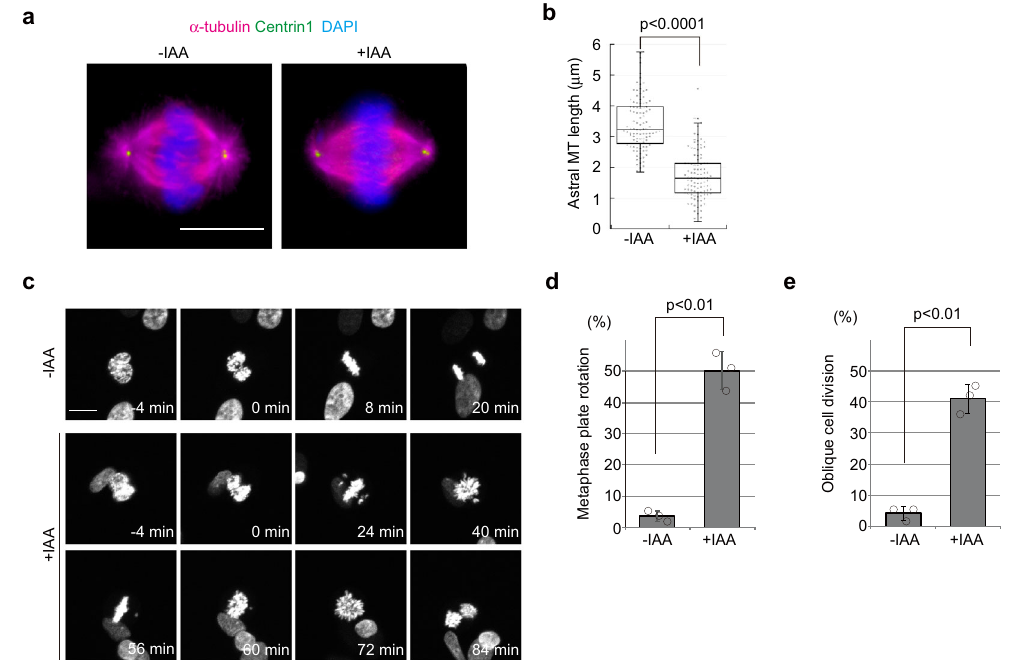
Fig. 4 Loss of CENP-E induces shortened astral MTs and oblique cell divisions. a , b Synchronized CENP-E-AID cells with a single thymidine block were released into fresh media for 8 h with or without indicated drugs and were co-immunostained with antibodies against α -tubulin (magenta) and centrin1 (green). Representative images of mitotic cells in each sample are shown (scale bar = 10 μ m). Length of astral MTs was measured and plotted in b ( N = 102, three independent experiments; whisker: 95% con fi dence interval; box: interquartile; center line: median). c Live-cell imaging of CENP-E-AID cells stably expressing H2B-GFP. Representative time-course images of control ( − IAA) or CENP-E KO cells ( + IAA) are shown (scale bar = 10 μ m). d Percentages of cells in which the metaphase plate was rotated within 1 h after NEBD are shown in the bar graph (>100 cells in total from three independent experiments; error bars: SD). e Percentages of oblique cell divisions (see methods for de fi nition) are shown in the bar graph (>100 cells in total from three independent experiments; error bars: SD). p -values were calculated by a Mann – Whitney U test ( b ) or unpaired t -tests ( d , e